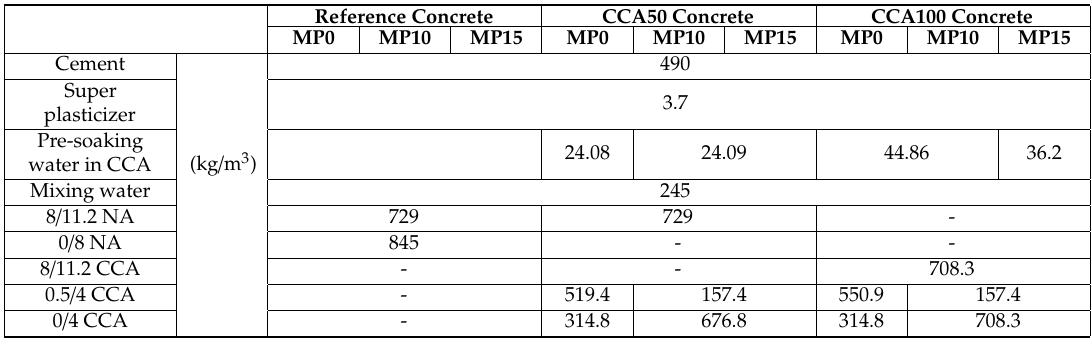
Table 3. Concrete recipes for mixes with and without mechanically pre-processed